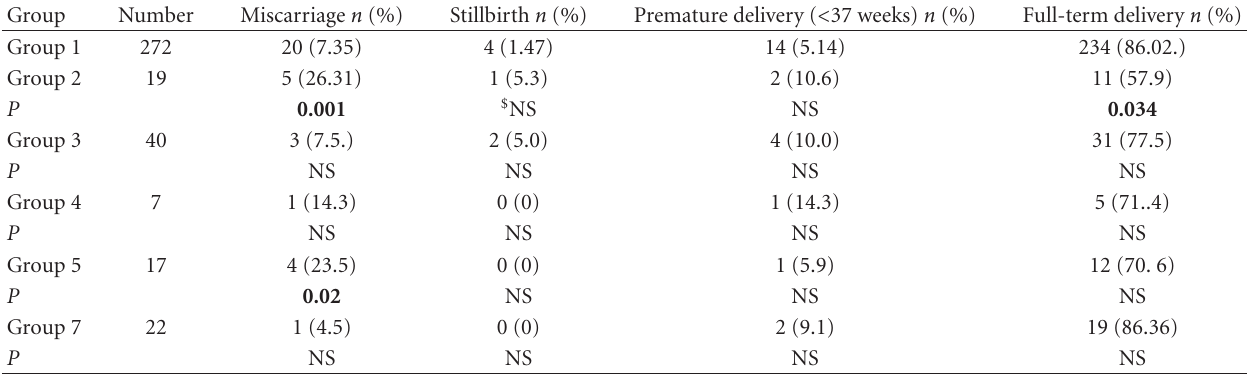
Table 2: Pregnancy outcome in various groups ∗ .